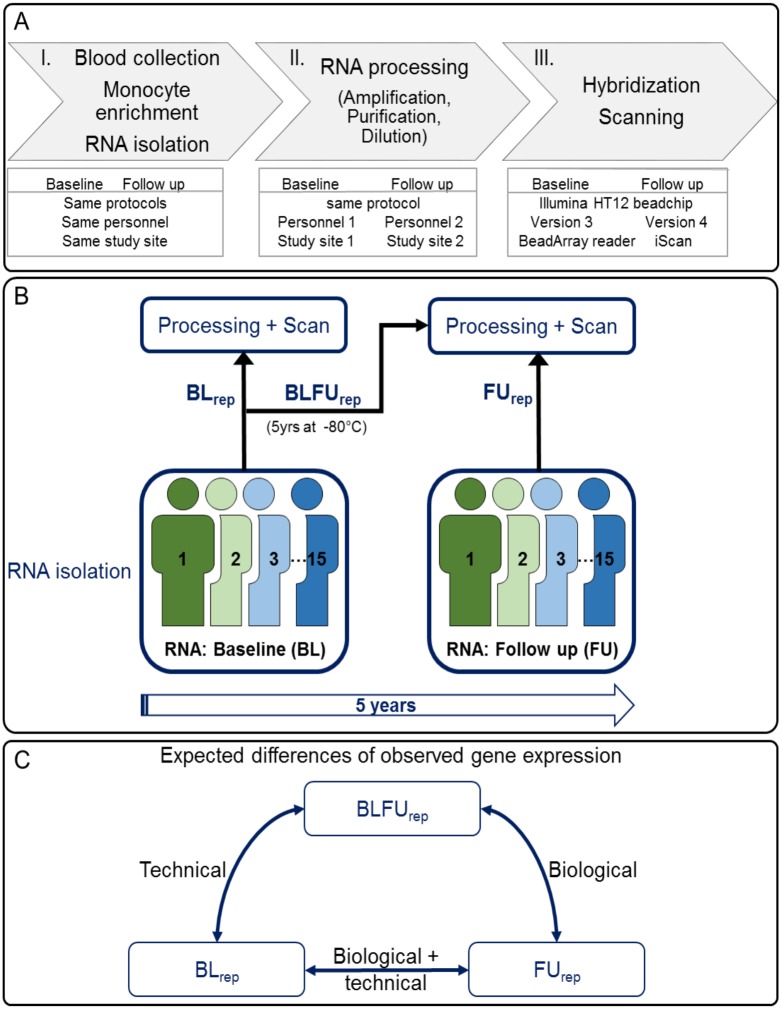
Experimental setting.A: Work flow of RNA extraction, processing and hybridization at study’s baseline (BL) and follow up (FU) examination. I) Blood collection, monocyte enrichment and RNA isolation were performed following the same standard operating procedures at the study center for both, BL and FU. II) RNA processing including amplification, purification, and dilution was performed using the same protocol at BL and FU, however, these steps were performed by different personnel a different study site. III) At BL, the Illumina HT12 BeadChips version 3 was used for hybridization and at FU the Illumina HT12 BeadChips version 4. At BL, the BeadArray Reader was used for the scan of the beadchips and at FU, the iScan was used. B: Definition of replicated samples. 15 subjects were randomly selected. At BL and FU, RNA was isolated from these 15 subjects. Based on the time point of RNA isolation and the time point of RNA processing, hybridization (preparation) and scan, three groups of sample replicates were defined: i) RNA isolated, prepared and arrays scanned at BL (BLrep), ii) RNA isolated at BL, stored for 5 years at -80°C, then prepared and arrays scanned at FU (BLFUrep) and iii) RNA isolated, prepared and scanned at FU (FUrep). C: Factors affecting observed gene expression differences between replicate measures. BLrep and BLFUrep differ by the time point of RNA preparation and array scan and thus reflect technical differences. For BLFUrep and FUrep, RNA preparation and array scan were performed at the same time point, therefore, observed variation mainly reflects biological differences. Observed differences between BLrep and FUrep comprise technical and biological variation. (rep = replicated sample).